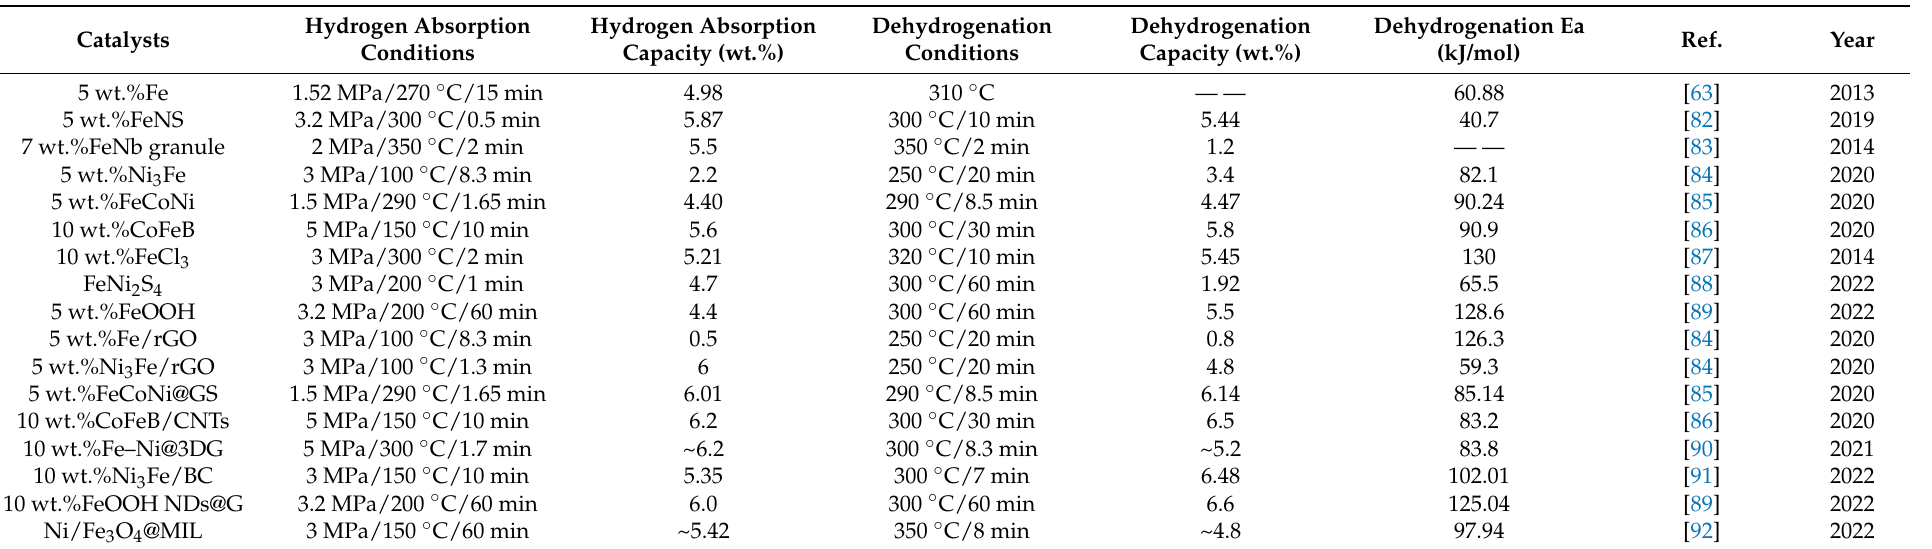
Table 4. Hydrogen storage performance of Mg/MgH 2 system doped with iron-based